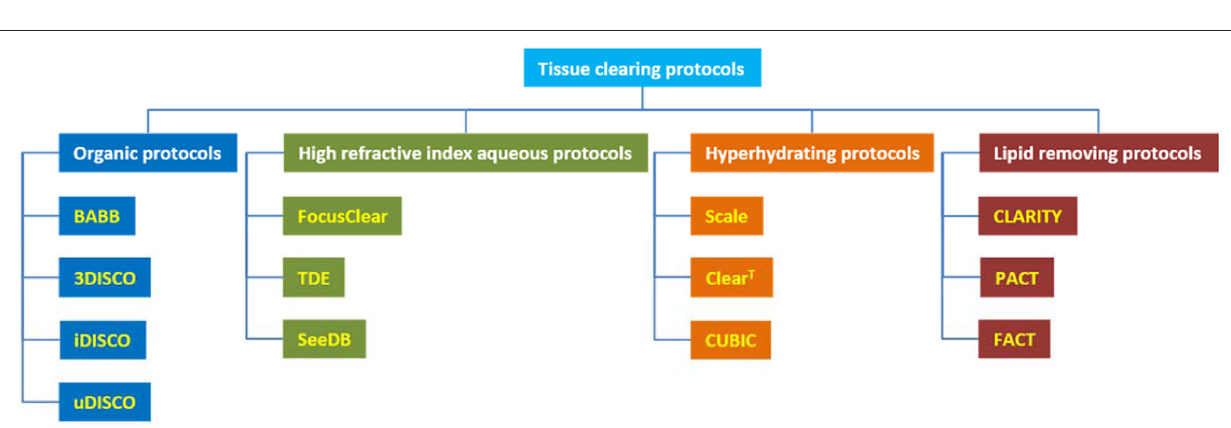
FIGURE 3 | Tissue clearing protocols for three-dimensional imaging of stem cell in in vitro and in vivo